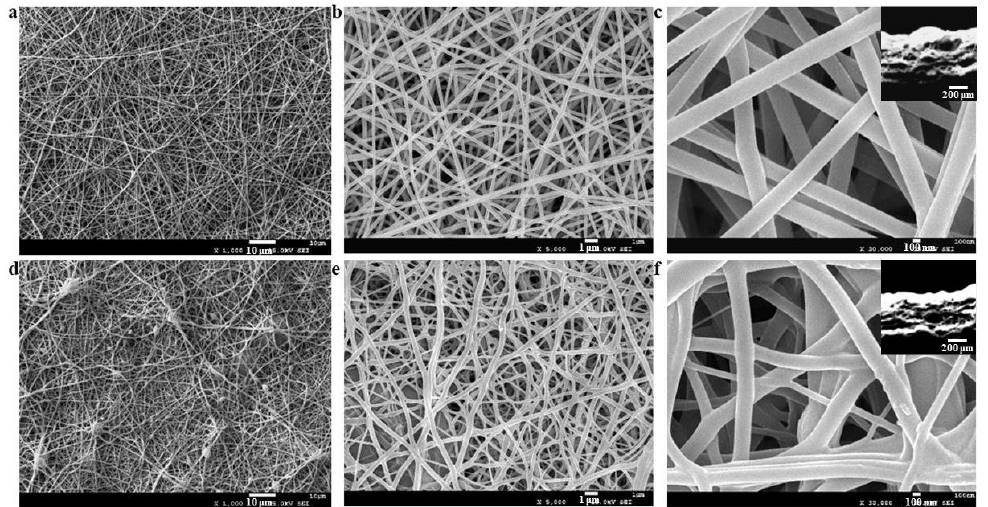
Figure 1. Scanning electron microscope (SEM) images of nanofiber films ( a – c ) polyvinyl alcohol (PVA); ( d – f ) nanofiber films PVA/tea polyphenol (TP)-9:1; and ( g – h ) the diameter distribution of the PVA ( d – f ) nanofiber films PVA / tea polyphenol (TP)-9:1; and ( g – h ) the diameter distribution of the PVA